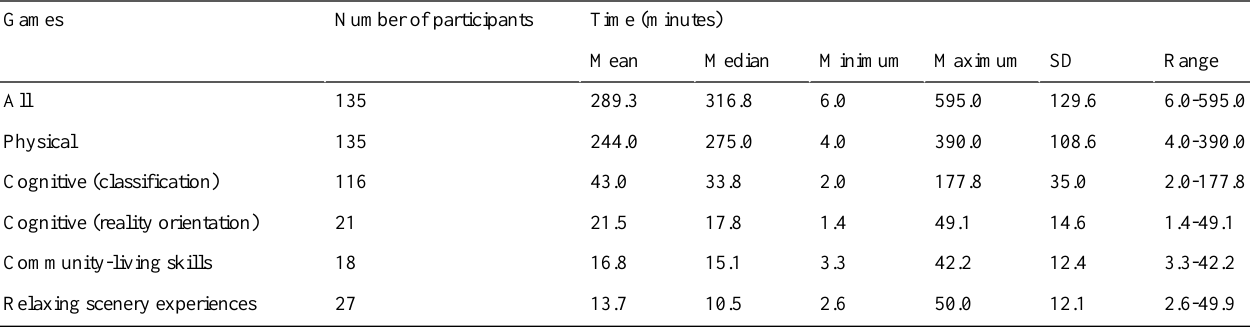
Table 5. Game time statistics according to game components.